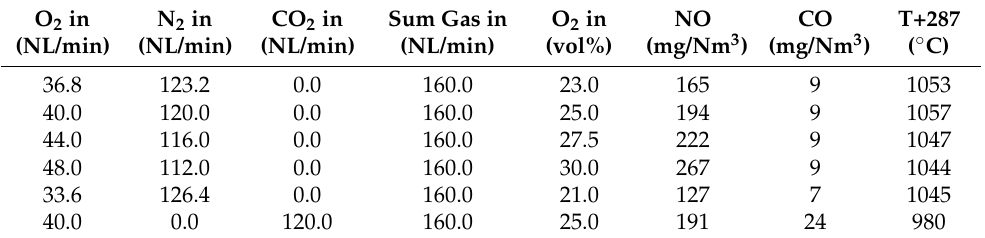
Table 3. Varying O 2 /N 2 concentrations, fixed total flow rate. Feedstock effect: 1.3 kg/h; reactor temperature set at 1000 ◦